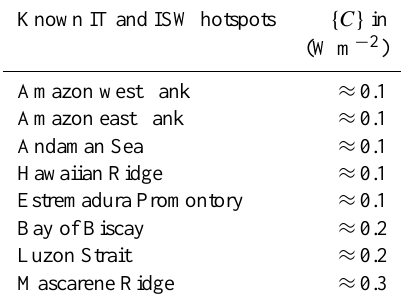
Table 2. Representative spatial averages for the depth-integrated and time mean conversion rates { C } given in the HYCOM simu- lations for known hotspots with elevated ISW activity. See text for more